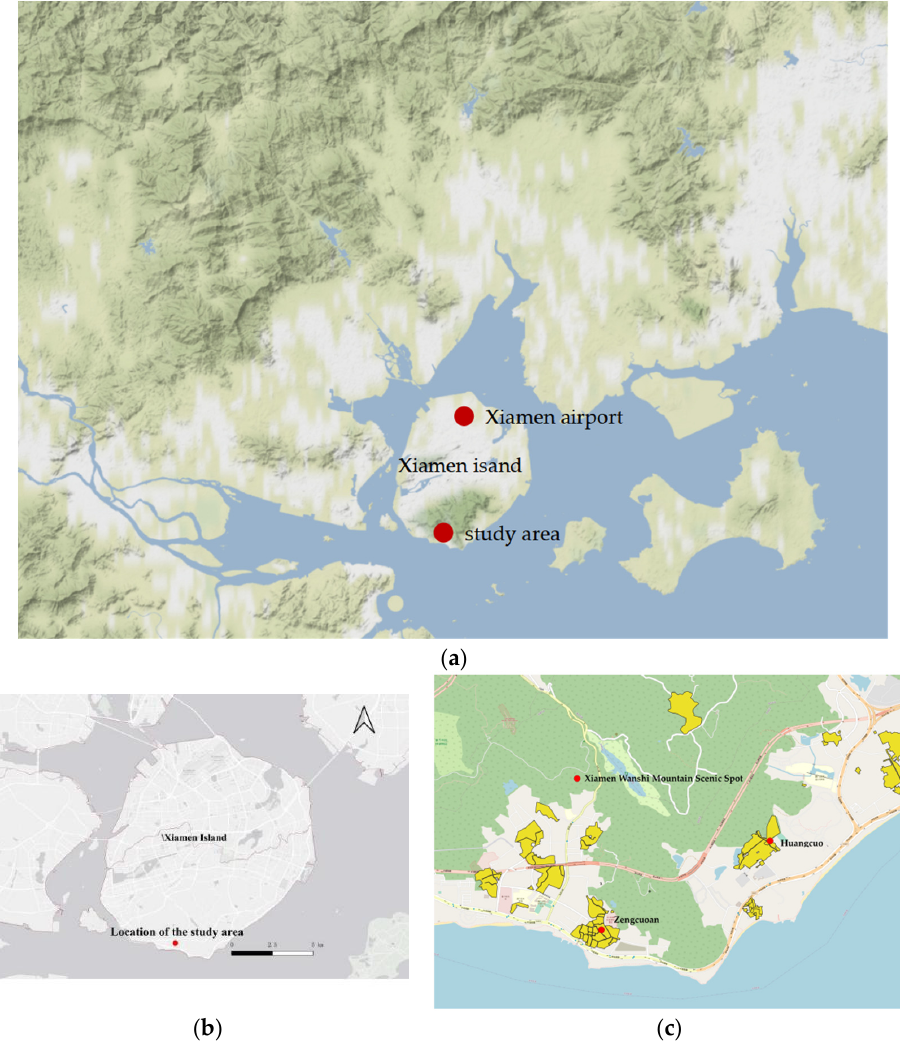
Figure 1. ( a ) shows the distance between the study case site and Xiamen Airport; ( b ) shows the location of the study case site on Xiamen Island; ( c ) shows the location of the study case site in relation to Xiamen Wanshi Mountain Scenic Area.Source: ( a ) is adapted from Stamen Terrain. ( b ) is adapted from Esri. ( c ) is adapted from OpenStreetMap.